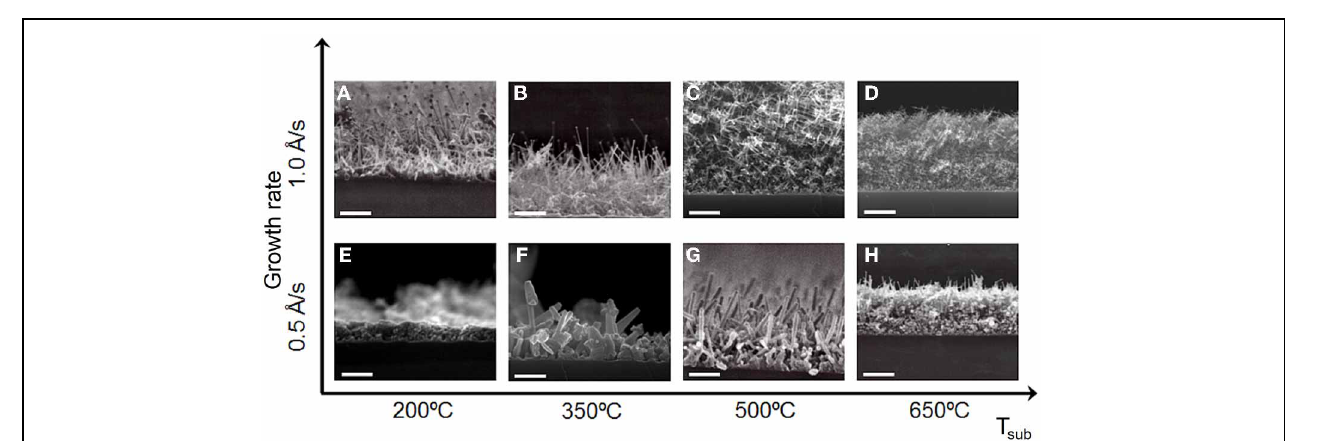
FIGURE 1 | Left: schematic of the angle-resolved reflectance setup. Right: schematic representation of thin film interference that cause reflections between two materials of different refractive indices. Here, the reflections from both interfaces interfere. For the NW coated surface, the graded refractive index from the air with multiple photon scattering